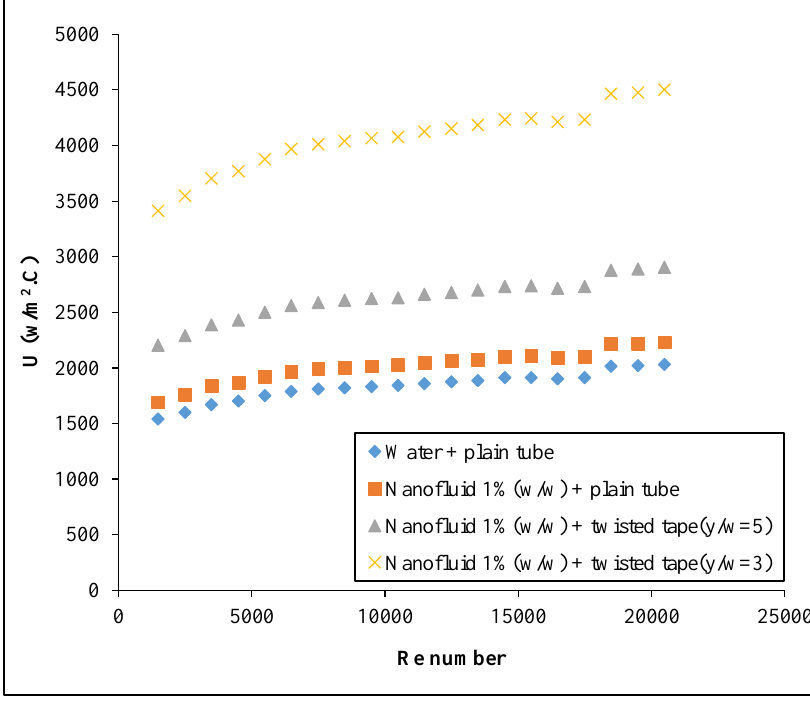
Figure 3. Variation of overall heat transfer coefficient with Reynolds